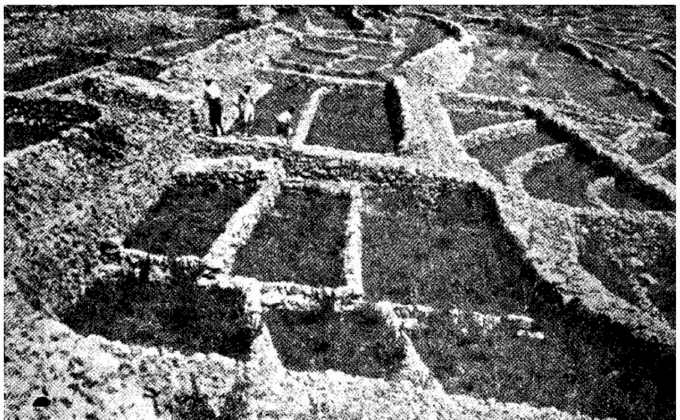
Figure 3. Well-maintained dry stone terraces surrounding the town of Cres in the late first half of the 20th century (Franjo Jardas